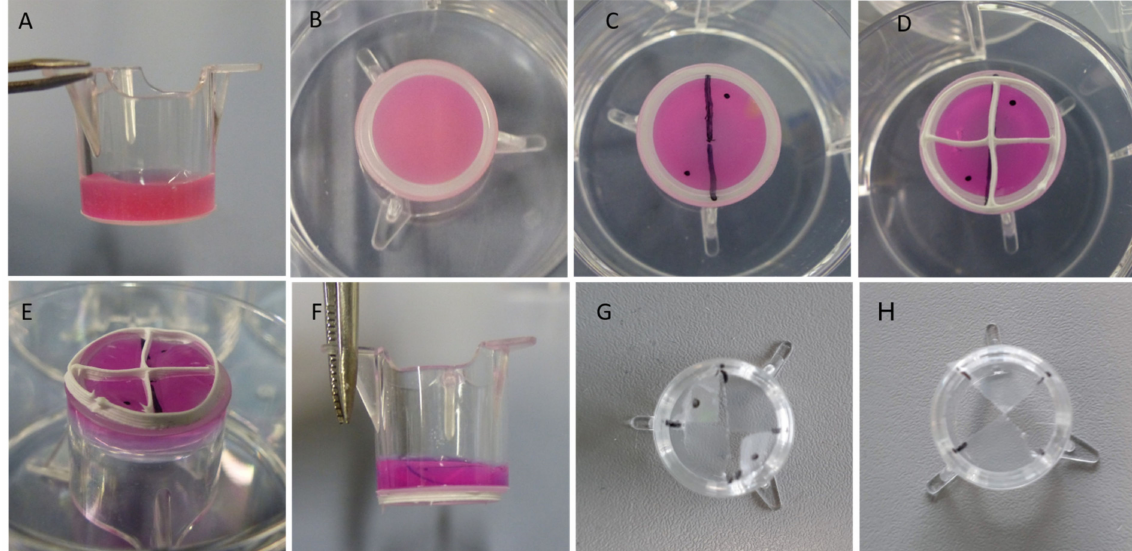
Figure 8. Experimental setup for the triple cultures of osteocytes, osteoclasts and osteoblasts. ( A ) For osteocyte maturation, human primary osteoblasts were embedded in neutralized collagen solution, which was allowed to gel in transwell inserts and cultivated for 14 days in the presence of osteogenic supplements in 12-well tissue culture plates. ( B ) The constructs were removed from the culture dishes and placed bottom-up into 6-well tissue culture plates. ( C ) The PET membrane of the inserts was marked with a sterile pen. ( D ) Silicon grids were placed to the basolateral side of the membrane. ( E ) Cell suspensions of osteoblasts and mature osteoclasts were pipetted to the different compartments of the grid (two compartments for each cell species). Constructs were placed in the incubator to allow cell adherence. ( F ) After 3 h of initial adherence, the constructs were transferred to 12-well tissue culture plates and were supplemented with osteocyte differentiation medium. ( G ) After 7 days of cultivation, the constructs were washed with PBS, gels were transferred to separate dishes for collagenase digest and membranes were cut with scissors. ( H ) Transwell insert with two membrane pieces seeded with osteoblasts (osteoclast-seeded membrane pieces were already transferred to separate